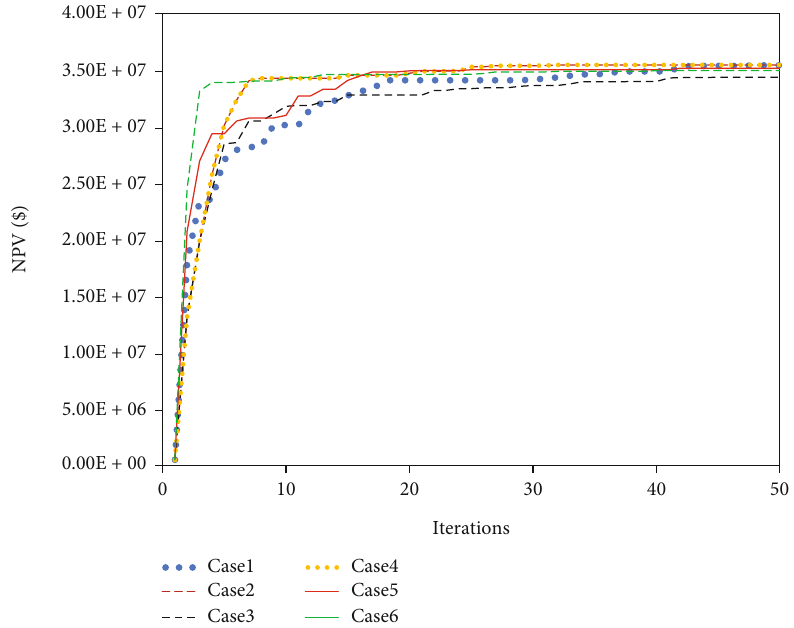
Figure 17: The NPV with respect to number of iteration based on six cases.